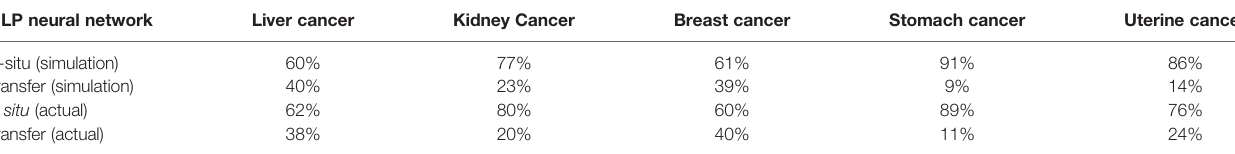
TABLE 3 | Unilateral modeling and simulation of recurrence